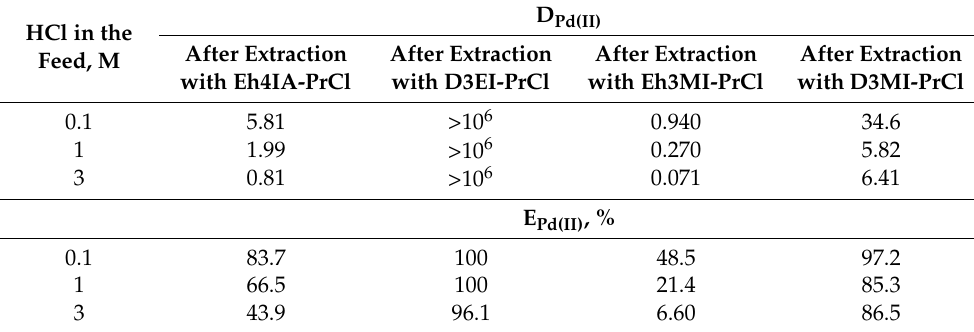
Table 2. Values of distribution ratios and extraction efficiency of Pd(II) with 5 × 10 − 3 M Eh4IA- PrCl, D3EI-PrCl, Eh3MI-PrCl, or D3MI-PrCl from aqueous solutions containing 0.1, 1, or 3 M HCl (A/O =